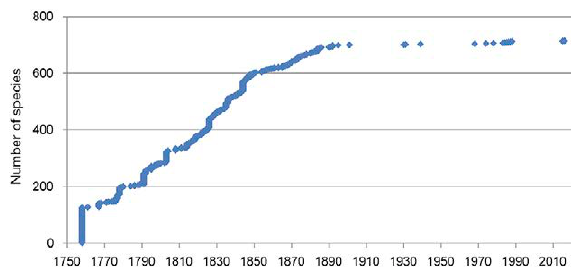
Fig. 5. – Cumulative number of species (“Present” and “Revisable”) present in Spanish waters of the Iberian Peninsula and the Balearic Islands, and known to Hidalgo (1917), plotted against their year of first description. This represents less than half of the 1976 species currently recorded. Some of the species were cited by Hidalgo with names now regarded as wrong, and were reassigned to species de- scribed later, or are now denoted under another name because the name then in usage is preoccupied or otherwise invalid. These are Nucula nitidosa, Nucula hanleyi, Emarginula octaviana, Parvioris ibizenca, Ringicula gianninii, Strobiligera brychia, Skeneopsis sul- tanarum, Manzonia vigoensis, Parvicardium vroomi, Emarginula christiaensi, Brocchinia clenchi, Odostomia carrozzai, Bela menk- horsti, Parviturbo ergasticus and Dendropoma lebeche .